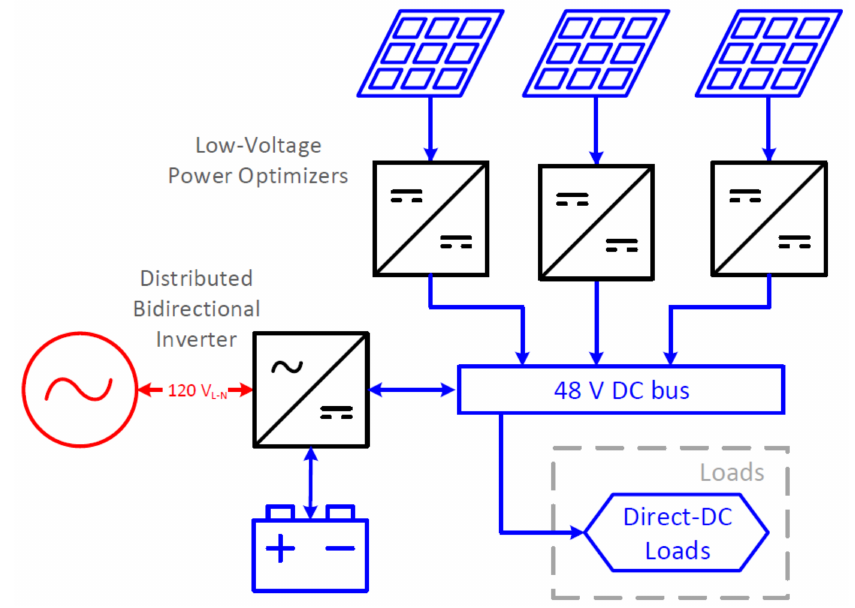
Figure 9. Direct-DC BIPV system powering local end